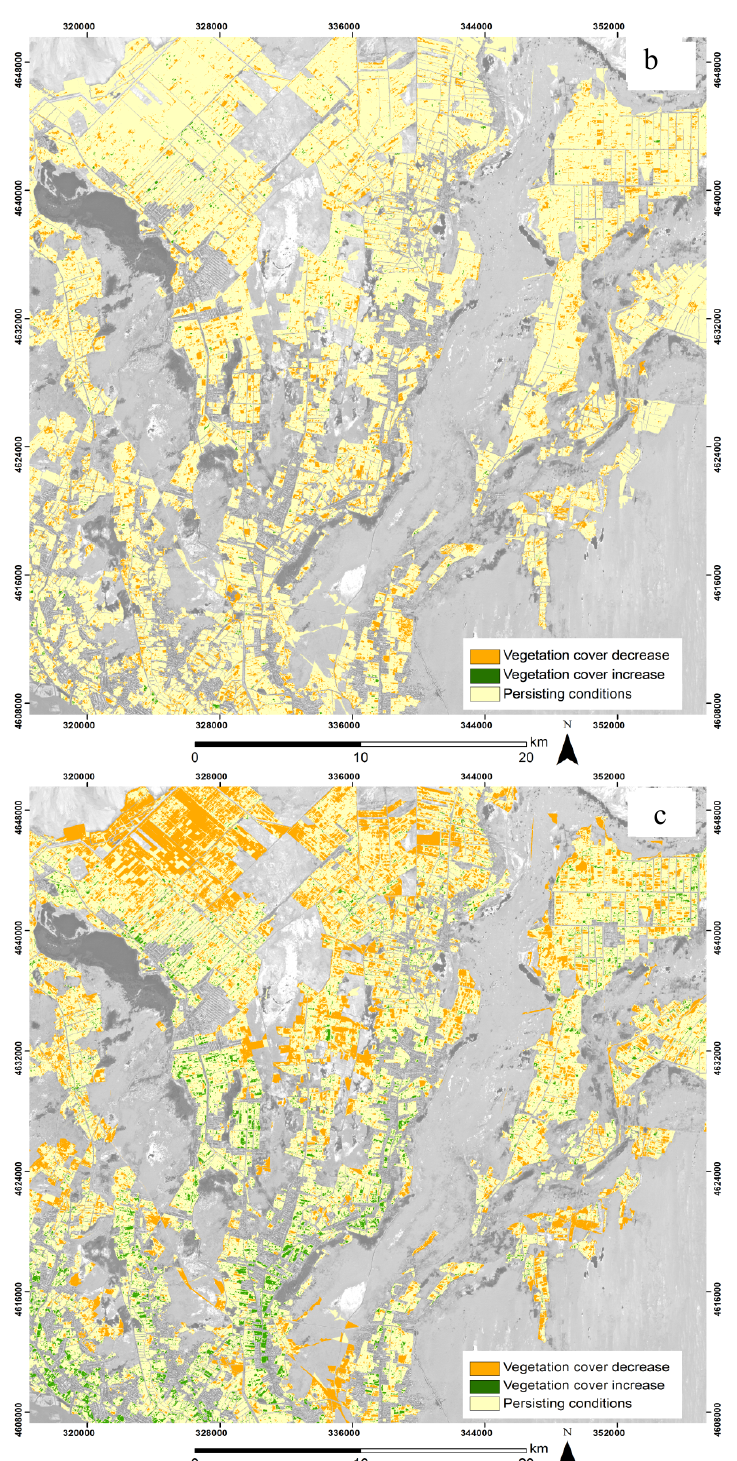
Figure 4. Results of change vector analysis based on the fraction images calculated from multitemporal 10 m SPOT data: ( a ) Overall change direction map for the years 1998–2010; ( b ) Change direction map for the years 2006–2010; ( c ) Change direction map for the years.